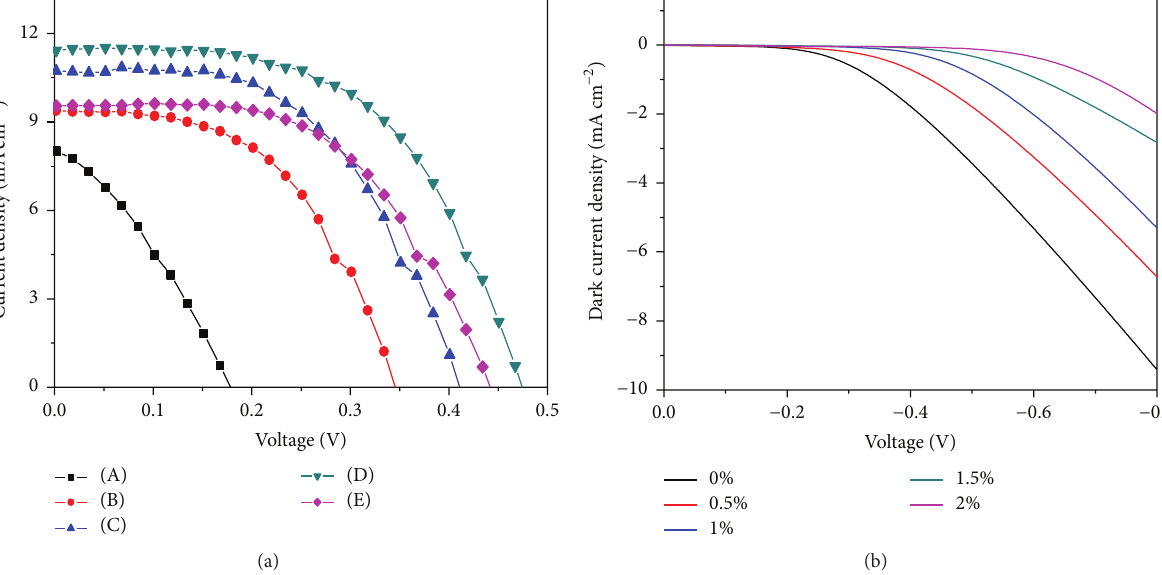
Figure 4: 𝐽 - 𝑉 characteristic of the DSCs based on the SnO 2 hollow microspheres doped with different Al content (a) and the corresponding dark current-voltage curves